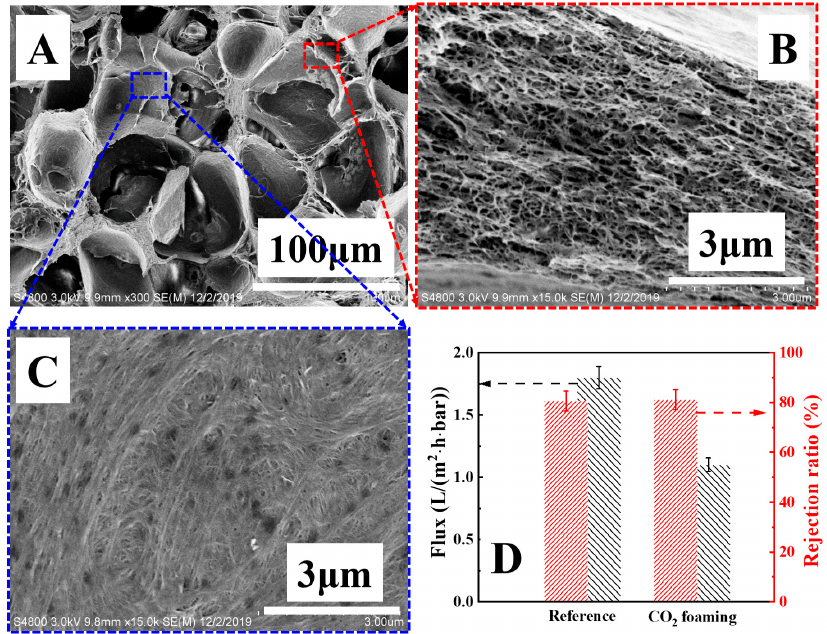
Figure 7. SEM images ( A – C ) of PVDF HPMs upon foaming with supercritical CO 2 and separation performance ( D ). The red and blue boxes represent the magnified images at the indicated position.